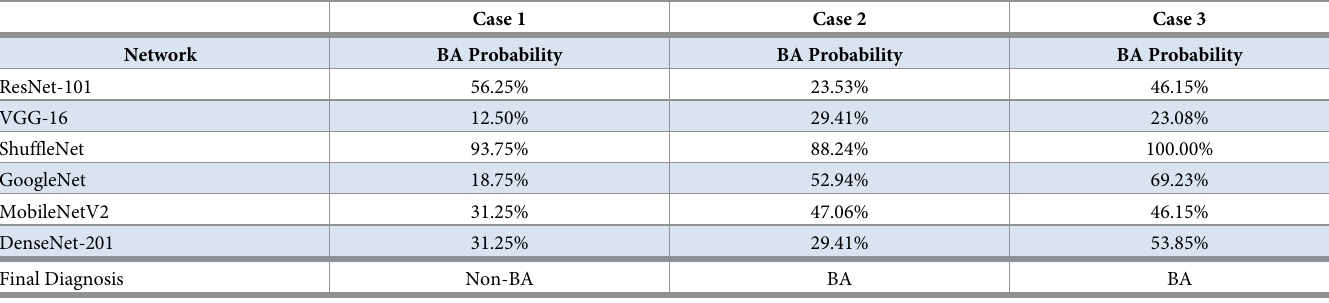
Table 5. Prediction results for BA of three successive